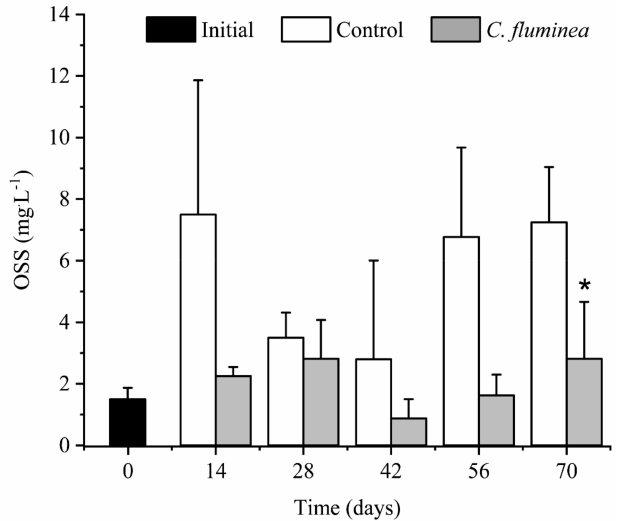
Figure 3. Organic suspended solids (OSS, mean ± SD) in different treatments over time. Asterisk indicates significant differences between the treatments and controls ( p <